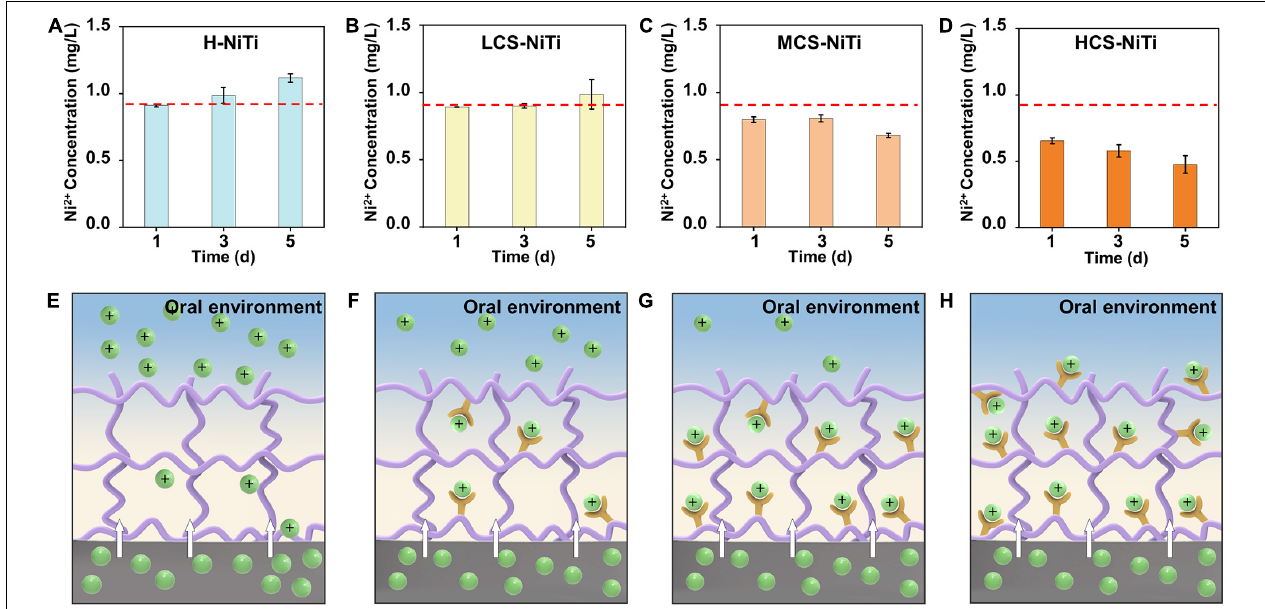
FIGURE 4 | The mechanism of Ni 2 + ion capture of CS-NiTi. (A–D) The quantitative analysis of Ni 2 + ion capture performance of H-NiTi, LCS-NiTi, MCS-NiTi, and HCS-NiTi. (E–H) Schematic of Ni 2 + ion capture property of CS-NiTi with different concentrations of Ni-catchers.